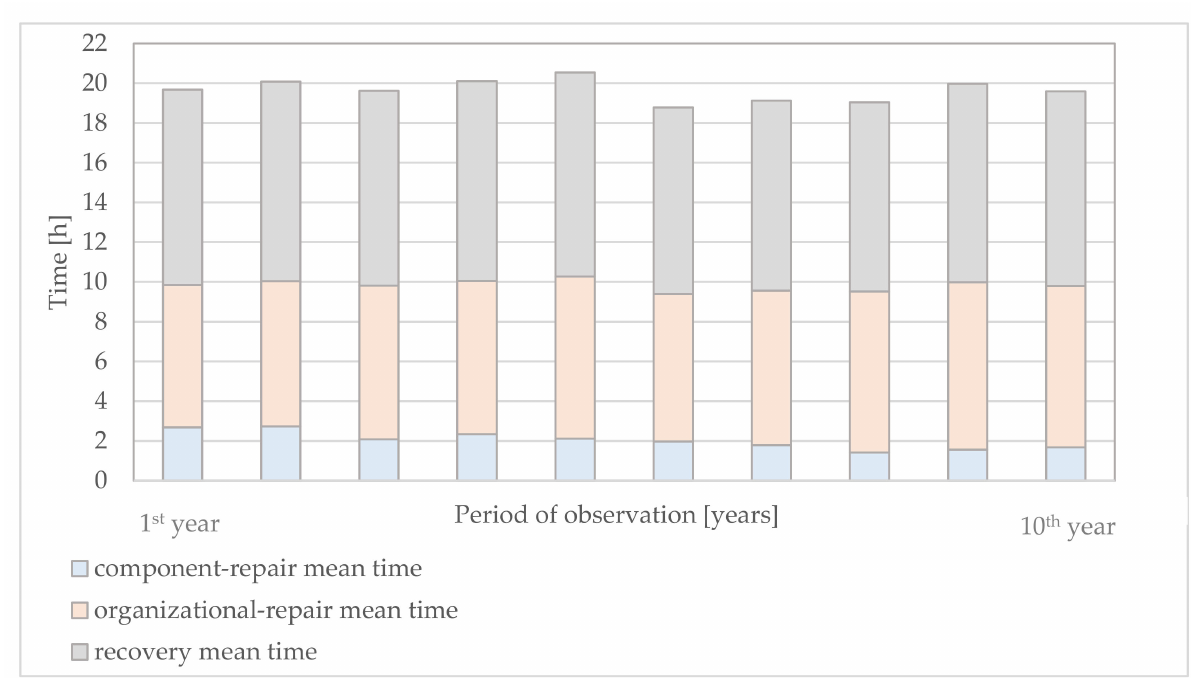
Figure 5. The component-repair meantime T c , the organizational-repair meantime T o , and the recovery meantime T r , per year.